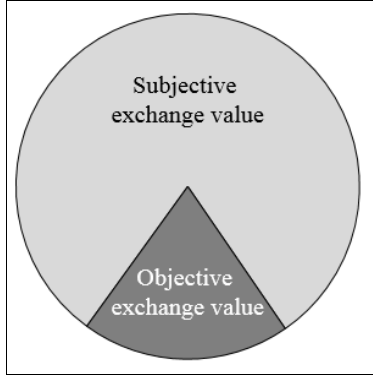
Figure 4. The objective and subjective part of the realized exchange value in science. Source: own illustration. Please note: the different sizes of the two fields illustrate the result from our study that scientists tend to receive a higher subjective than objective exchange value from disseminating their research. The fraction of the subjective versus objective value, however, does not indicate a specific ratio.